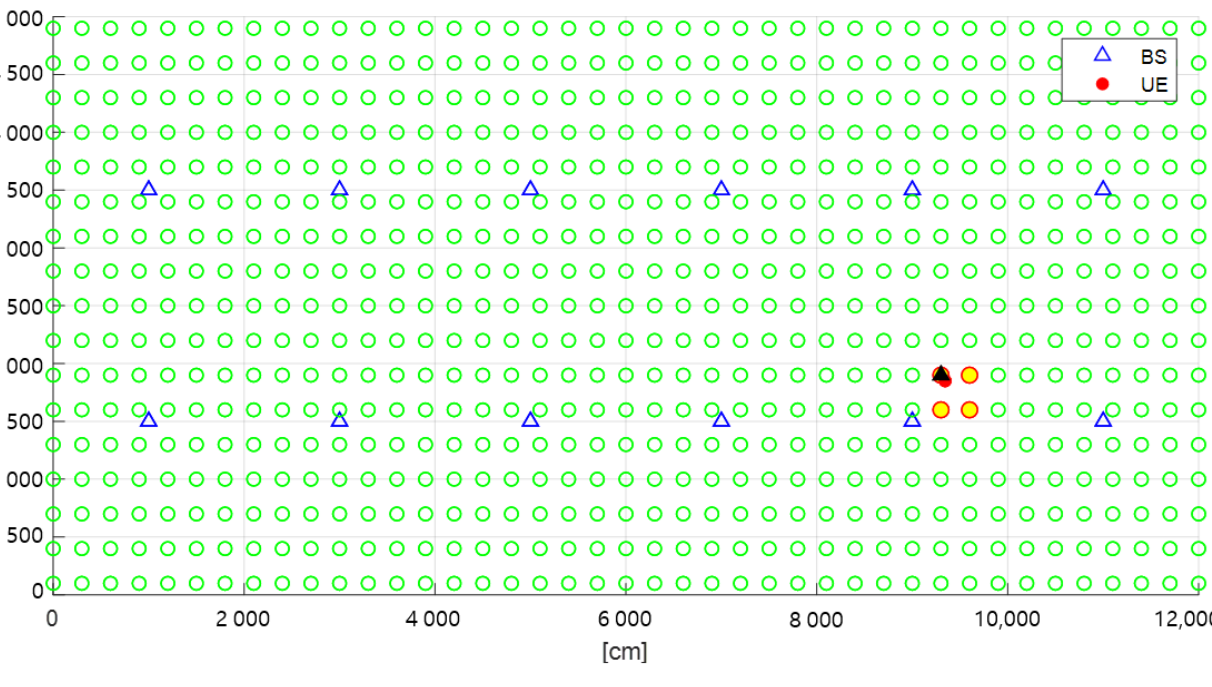
Figure 7. Result of final SP by using PSO.